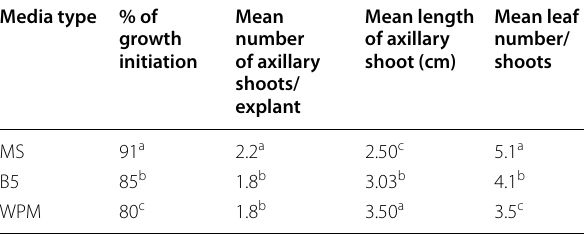
Table 1 Effect of MS, B5 and WPM on shoot initiation during the establishment stage of L. barbarum